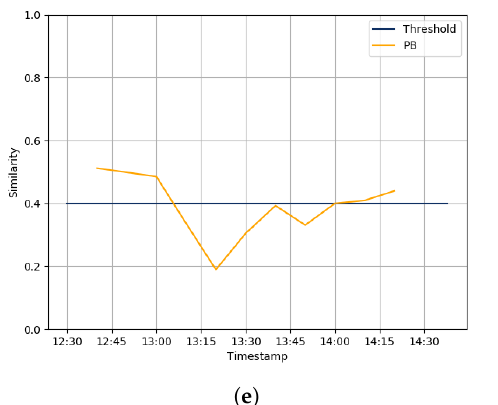
Figure 10. Predominant behavior of five different users during a malware attack. ( a ) User A. ( b ) User B. ( c ) User C. ( d ) User D. ( e ) User E.